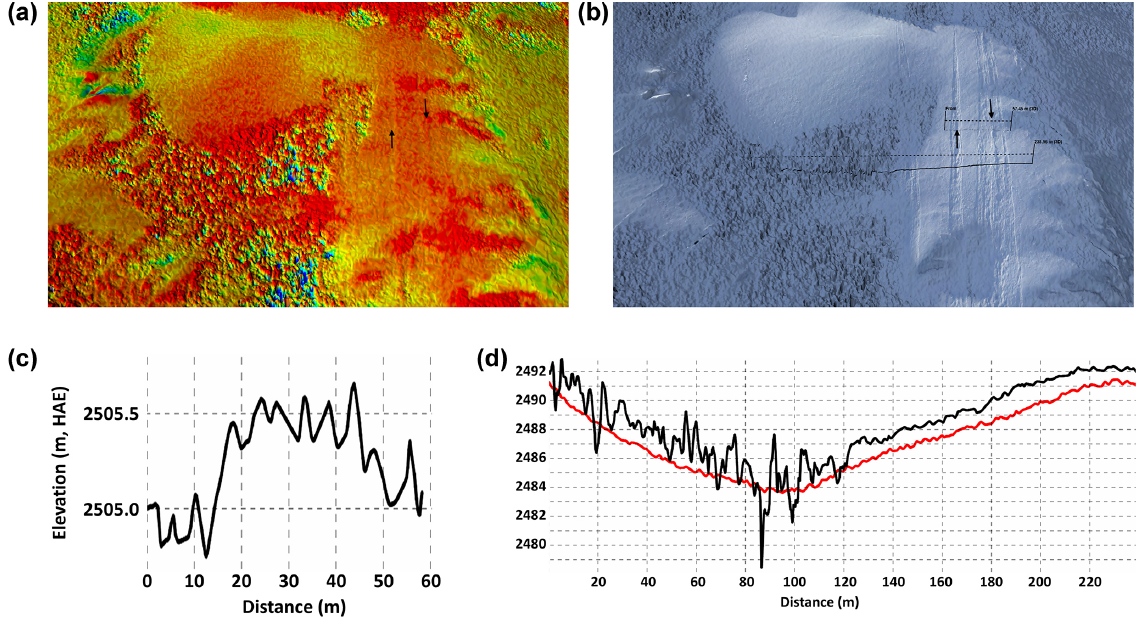
Figure 8. Spatially coherent grooves seen in a 22 April 2014–6 July 2015 difference image on Mt. Isto ( a , arrows) are clearly revealed in the July orthoimage (b) to be caused from a small avalanche. As seen in (c) , the left arrow points to a ∼ 20cm chute and the right arrow points to a ∼ 20cm ridge between chutes on this ∼ 40 ◦ slope. Resolving 20cm features like this requires centimeter-scale signal detection, despite the noise being on the 5–20cm level. This snow fell recently and is over a meter thicker than in 2014, located just downhill from the 5–10m cornices found in Fig. 5. (d) In the deepest shadows of this fresh snow, the noise level increased ∼± 1m (up to 10m, not shown), but these regions were quite small compared to the whole. Note that the 2014 data (red line) show no such